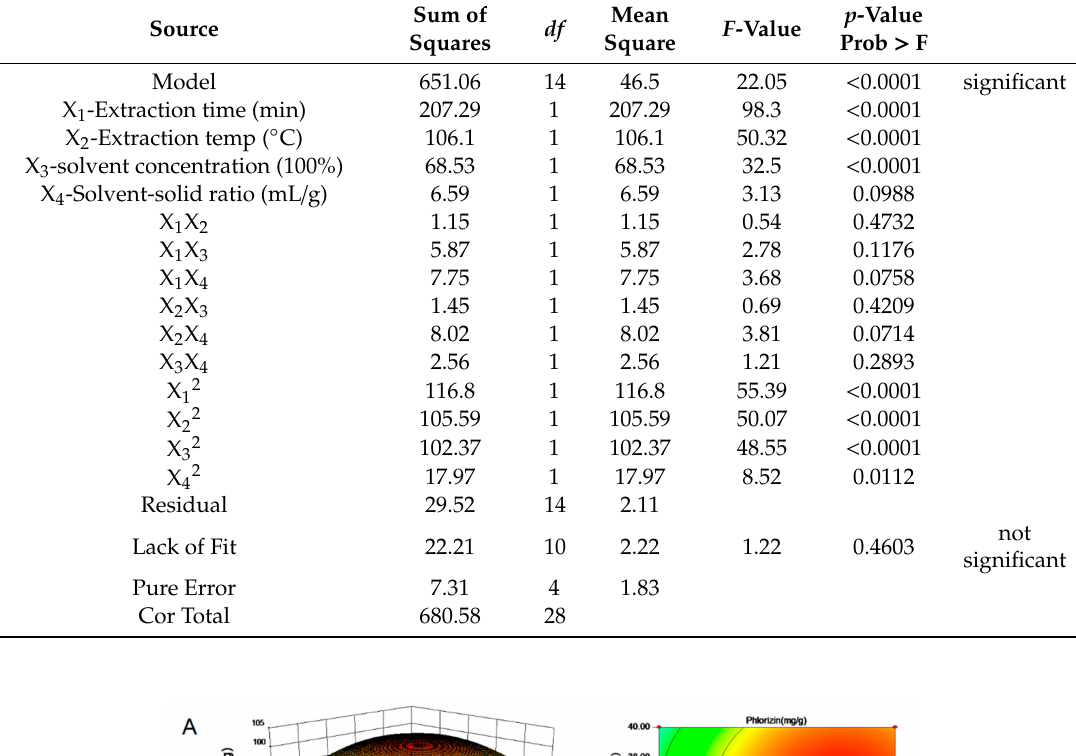
Table 3. Analysis of variance for the fitted quadratic polynomial model for extraction of